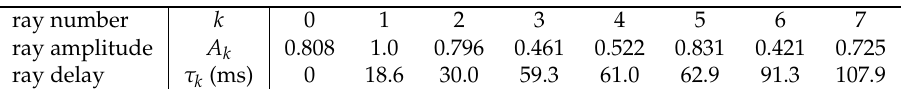
Table 4. Multipath channel parameters.